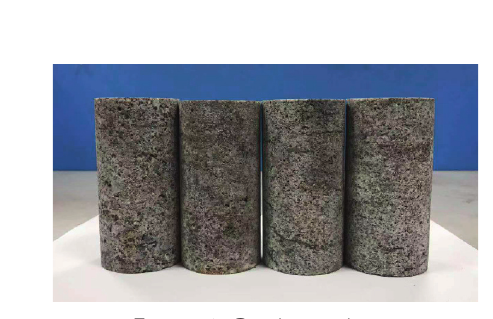
Figure 1: Granite specimen.